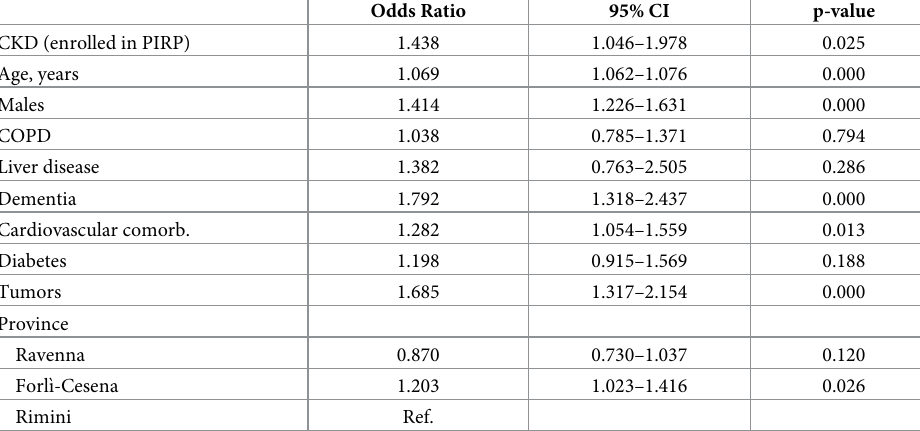
Table 4. Predictors of in-hospital COVID-19